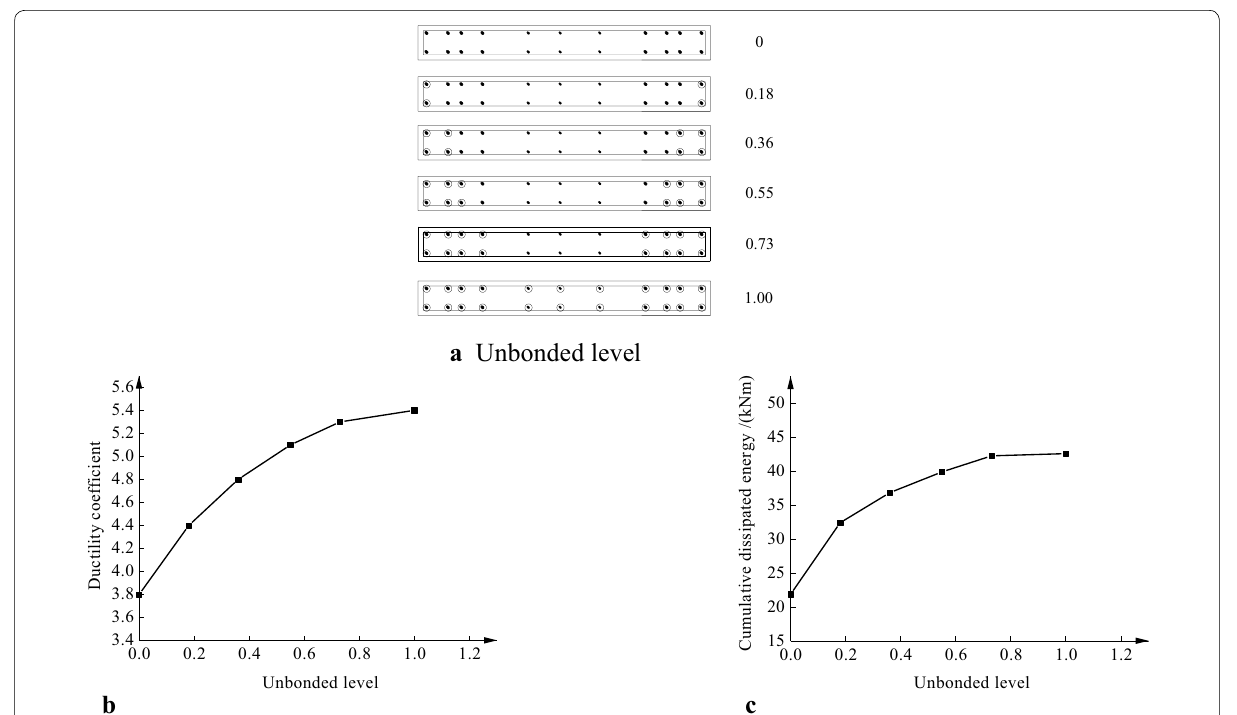
Unbonded level Fig. 15 Effect of unbonded level on b ductility and c energy dissipation. a The rebars in cycles are unbonded, others are bonded.